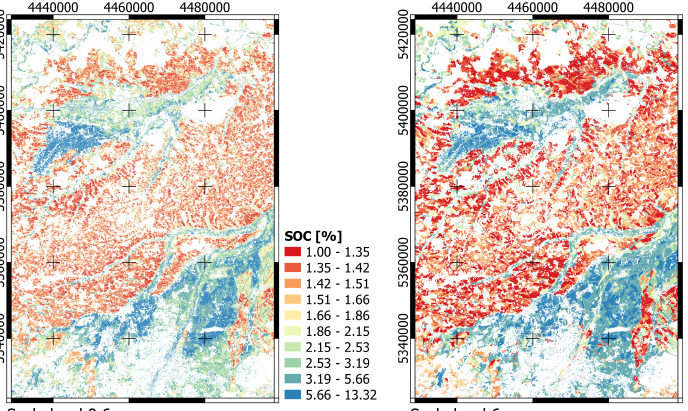
Figure 9. Predicted SOC content (%) values for scale level L = 0.6 and parametrization variant terrain attributes + SCMaP-SRC (TA+SRC) (left) as well as scale level L = 6 and parametrization variant terrain attributes (TA) (cf., Table 3 and Figure 8a,f). Projection: EPSG